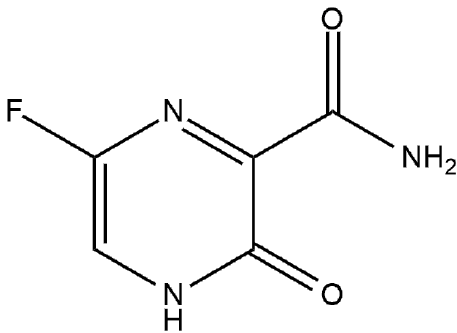
Figure 1. Chemical structure of favipiravir.